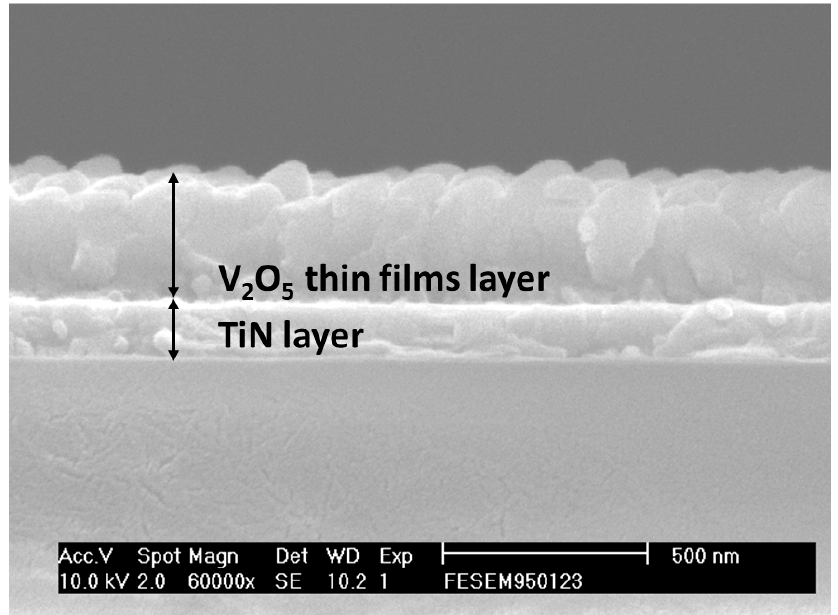
Figure 2. The cross-sectional images of the vanadium oxide thin films from RRAM devices.